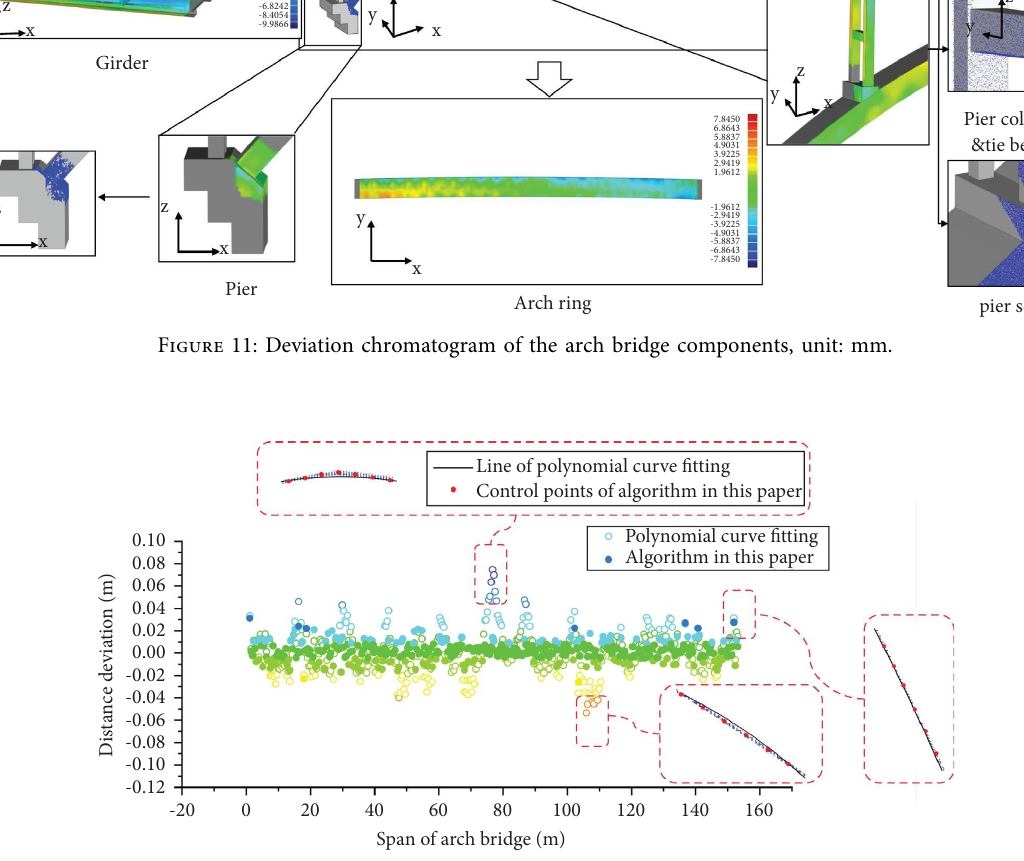
Figure 12: Accuracy analysis of arch ring linear algorithm.